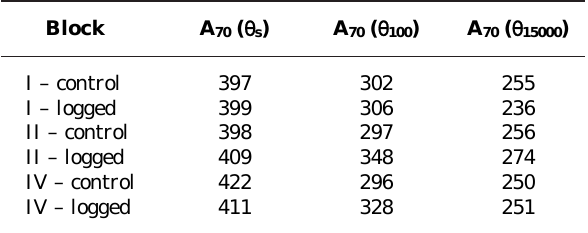
Table 3. Values of soil water storage (A), in mm, for a profile down to 70 cm, considering the saturated profile ( θθθθθ ) at field capacity s conditions ( θθθθθ ) and at the permanent wilting 100 point ( θθθθθ ), in the control plots and in 15.000 selectively logged